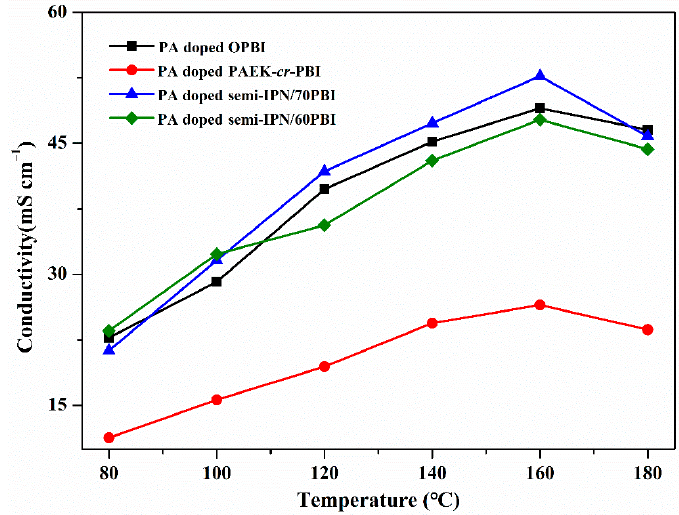
Figure 7. Proton conductivities of PA doped membranes.